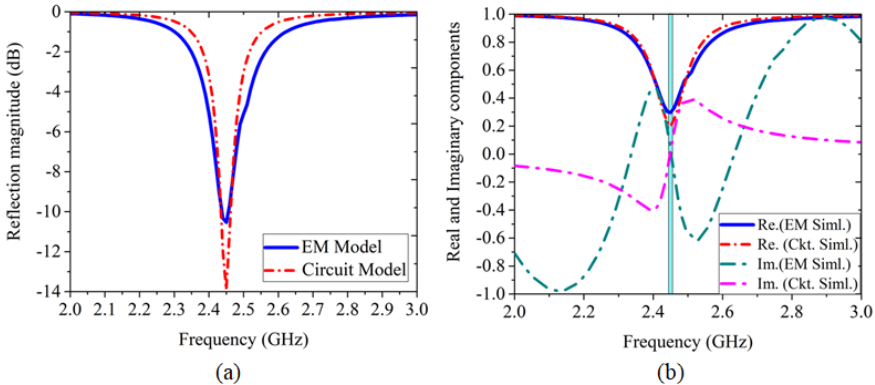
Figure 6. The simulated EM model and circuit model of AMC-MS unit cell: ( a ) Reflection magnitude, dB and ( b ) real & imaginary components. The equivalent circuit model parameters of the proposed unit cell are given by: R = 75 Ω , C1 = 0.02255 pF, L1 = 187.31 nH, C2 = 0.2 pF, L2 = 0.05